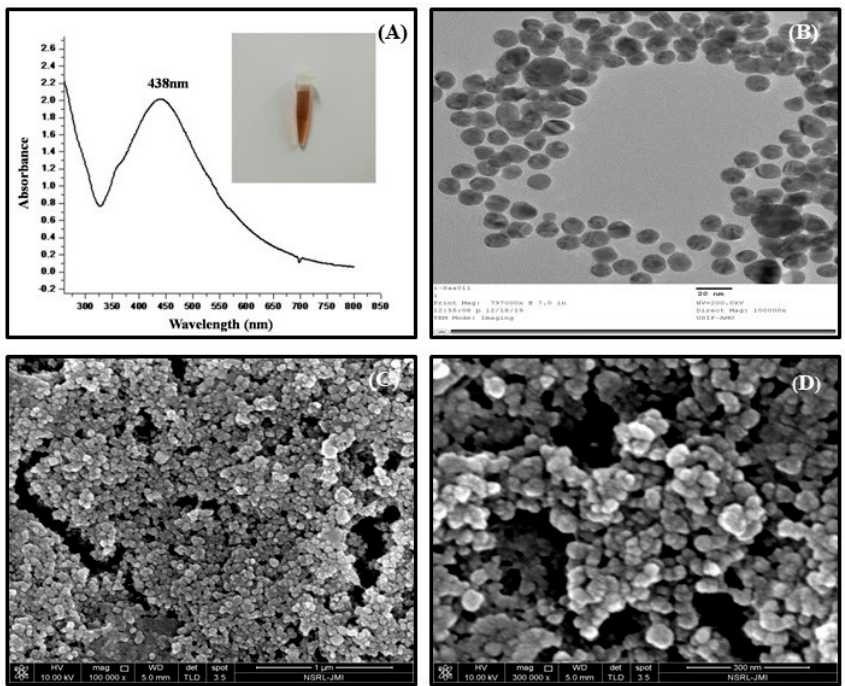
Figure 1. Characterization of AgNPs using ( A ) UV–visible spectrum ( λ max = 438 nm), ( B ) transmission electron microscopy (size ~26 nm), ( C ) scanning electron microscopy (size 27–33 nm) at scale bar 1 µ m, ( D ) scanning electron microscopy image at scale bar 300 nm.